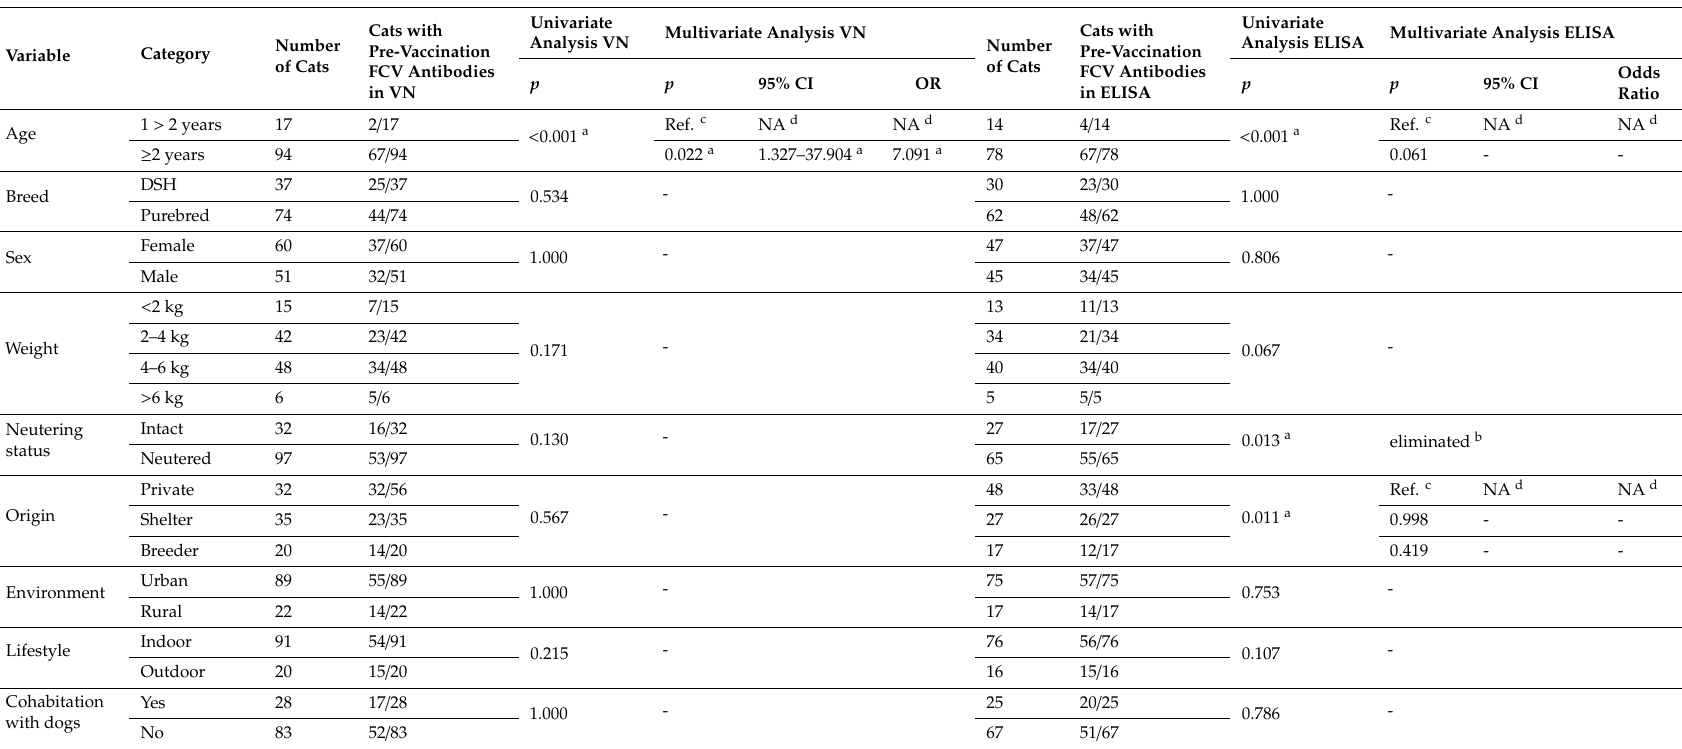
Univariate Analysis ELISA